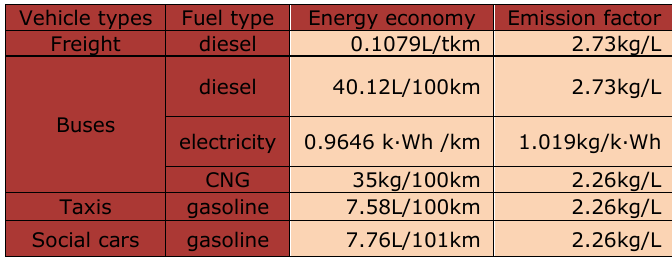
Table 1. Energy economy and emission factor for various vehicle and fuel